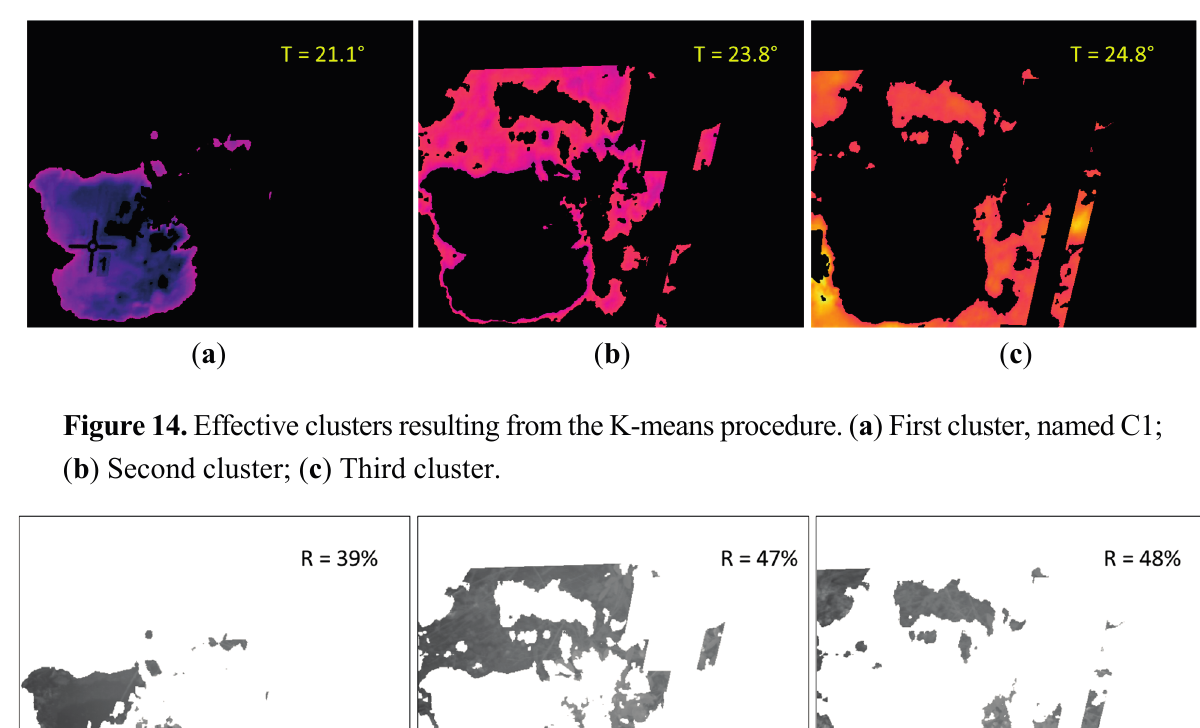
Figure 13. ( a ) Classification map; ( b ) Mask generated from the classification map.